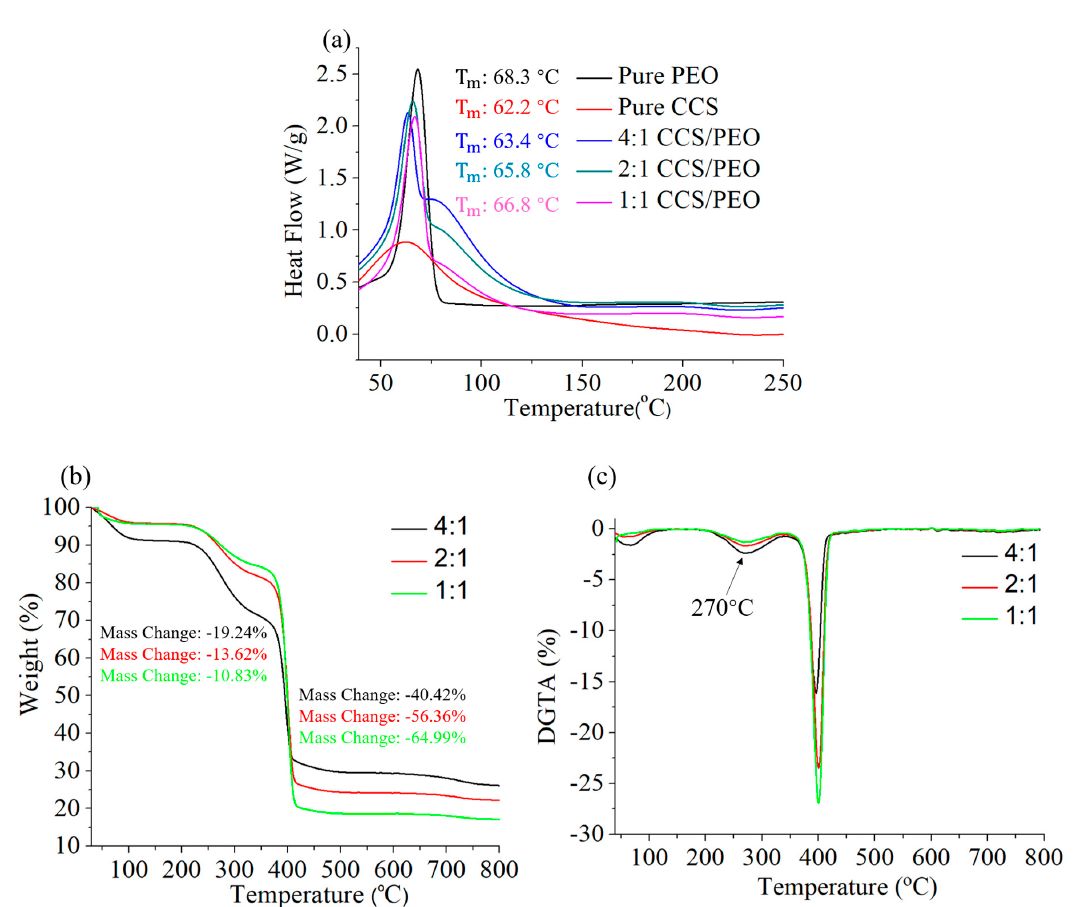
Figure 6. Thermal behaviors of the different nanofibers: DSC ( a ), TGA ( b ) and DTGA ( c ).